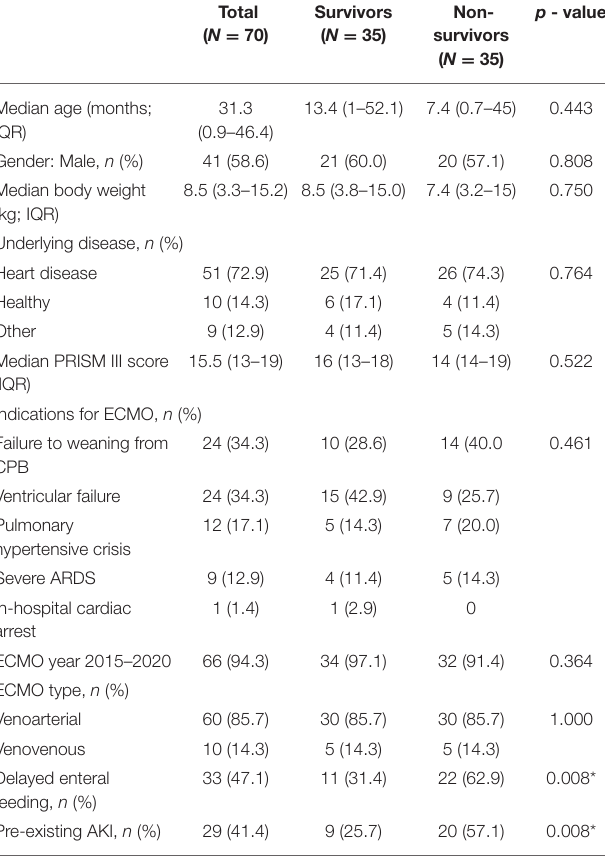
TABLE 3 | Logistic regression analysis for associated risk factors with mortality.